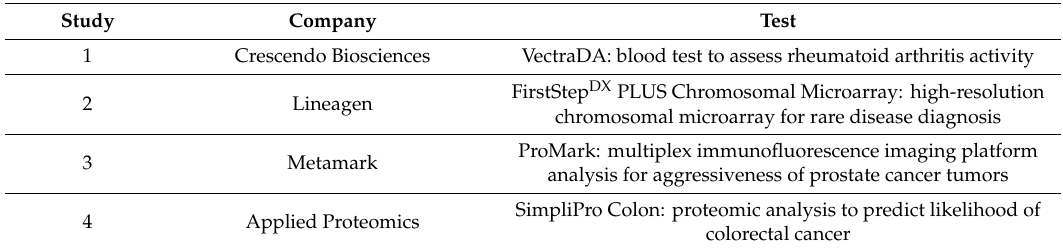
Table 1. Study sponsors and test